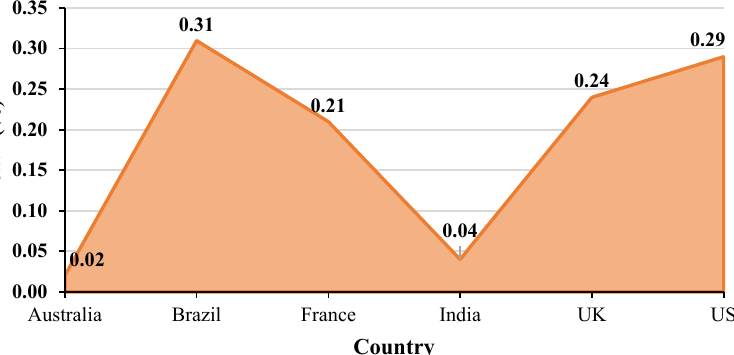
Figure 14. Total deaths in Australia and the most affected countries from 4 January 2020 to 22 March 2022 [64].